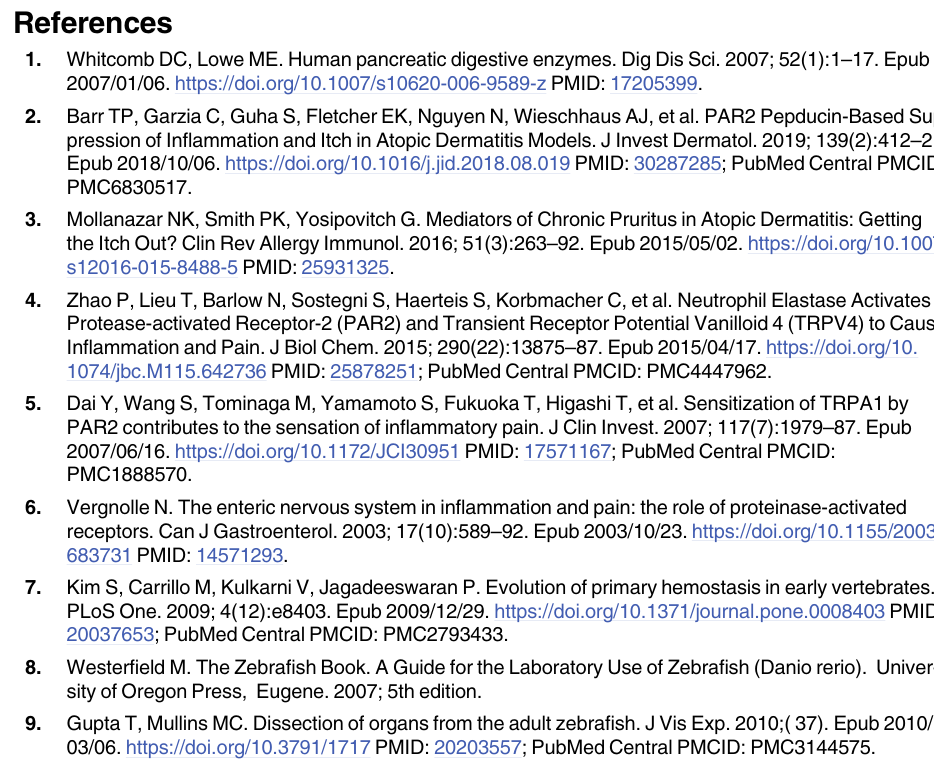
S3 Fig. Raw image of Fig 2G. Raw image of agarose gel that is shown in Fig 2G is included. (PDF) S1 Video. Aversive response of zebrafish larvae to trypsin. Video showing the larvae moving away from trypsin placed on the right side of the tank. (MP4) S2 Video. Aversive response of adult zebrafish to trypsin. Video showing the adults moving away from trypsin placed on the left side of the tank.